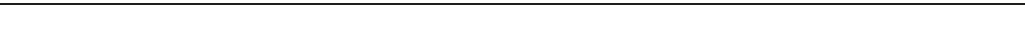
Fig. 6 Cellular uptake mechanism of the quantum probe. a Schematic representation of the endocytosis mechanism. b Quantum probe was internalized by energy-dependent endocytosis. (i) TEM images of cells reveal cellular uptake and internalization of the quantum probe. Scale bar = 2 µ m. (ii) Cell TEM images reveal evidence of the quantum probe dispersed in the nucleus of cells. Scale bar = 500 nm. (iii) TEM images of the cells incubated 4 °C did not show cellular uptake of the quantum probe, indicating ATP-driven endocytosis mechanism. Scale bar = 2 µ m. c Fluorescence images showing illuminated particles, indicating internalization of the quantum probes. Scale bar = 10 µ m. (p) SEM of cells (scale bar = 10 µ m), (q) line EDX ( “ x ” axis is displayed in µ m and “ y ” axis displays arbitrary units), (r) map EDX (scale bar = 10 µ m), (s) elemental EDX ( “ x ” axis is displayed in keV and “ y ” axis displays intensity) of cells outlined in green. Evidence of the presence of the quantum probe within the cells (p, q, r, s). Scale bar for p and r, 10 µ